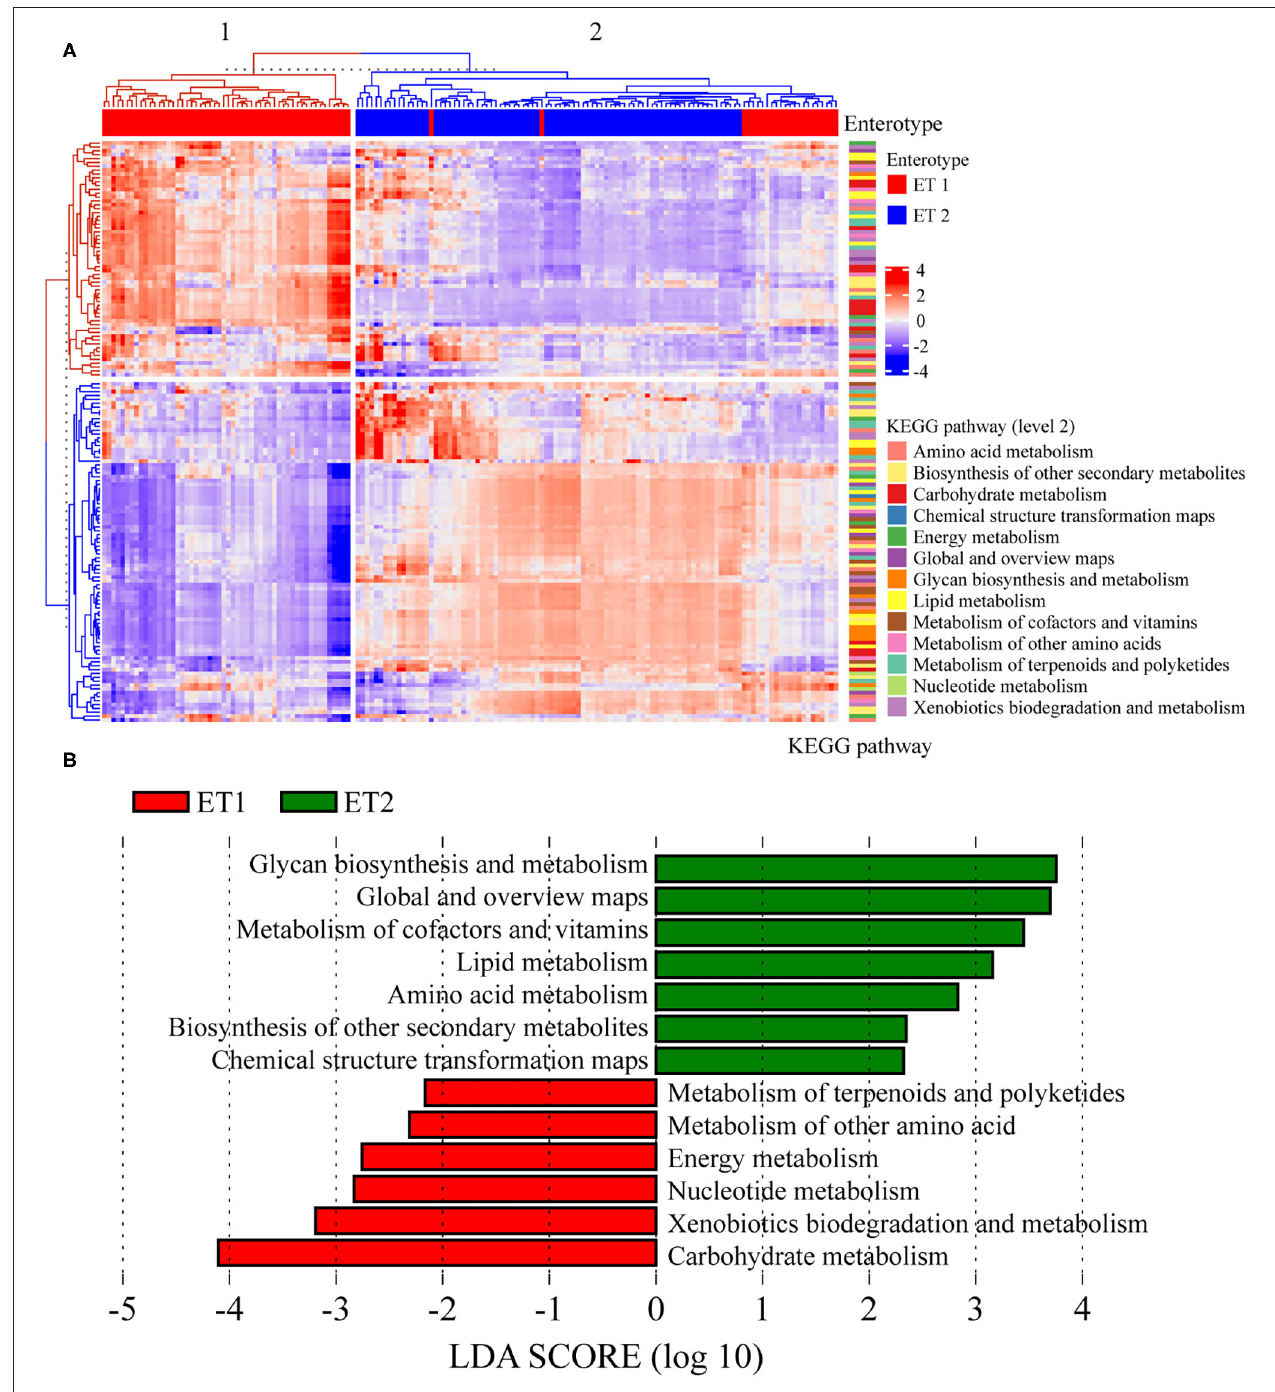
FIGURE 7 | Prediction of the function of bacterial communities based on 16S rRNA sequencing. (A) The third level of the Kyoto Encyclopedia of Genes and Genomes (KEGG) pathway was shown in the heatmap. (B) Analysis for the KEGG pathway (level 2) using LEfSe.